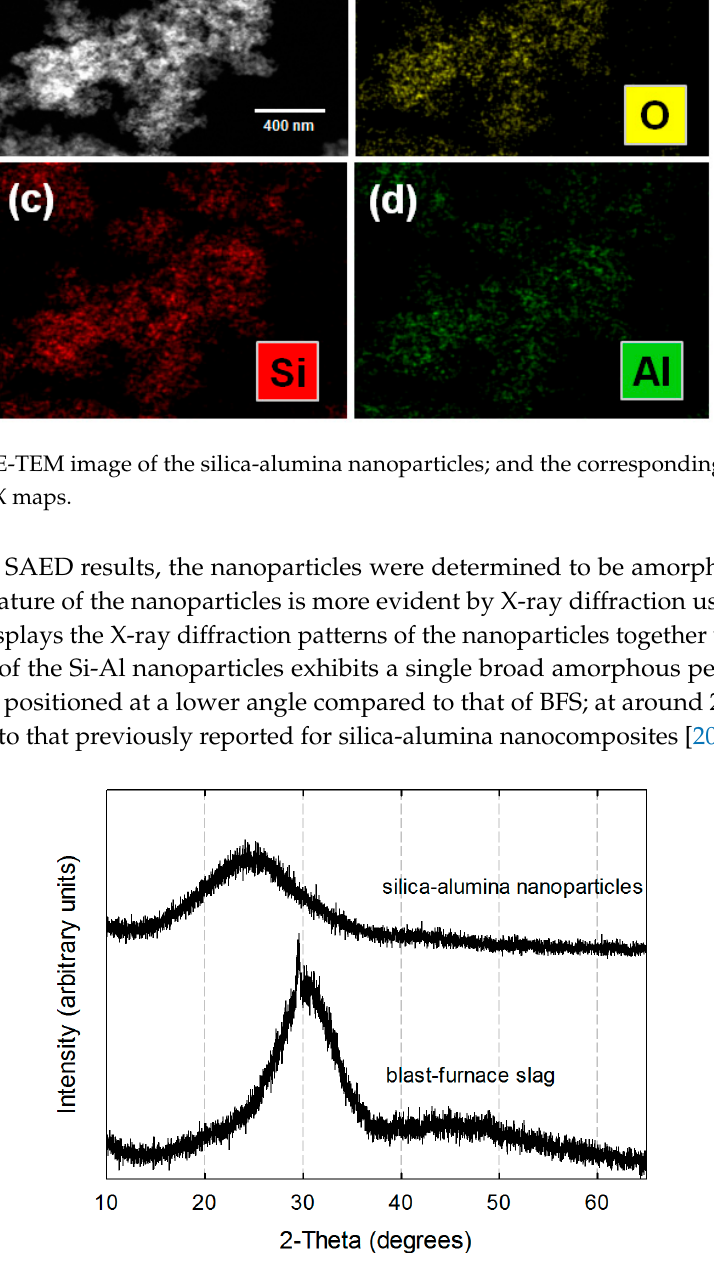
Figure 6. XRD patterns of blast-furnace slag and the silica-alumina nanoparticles.